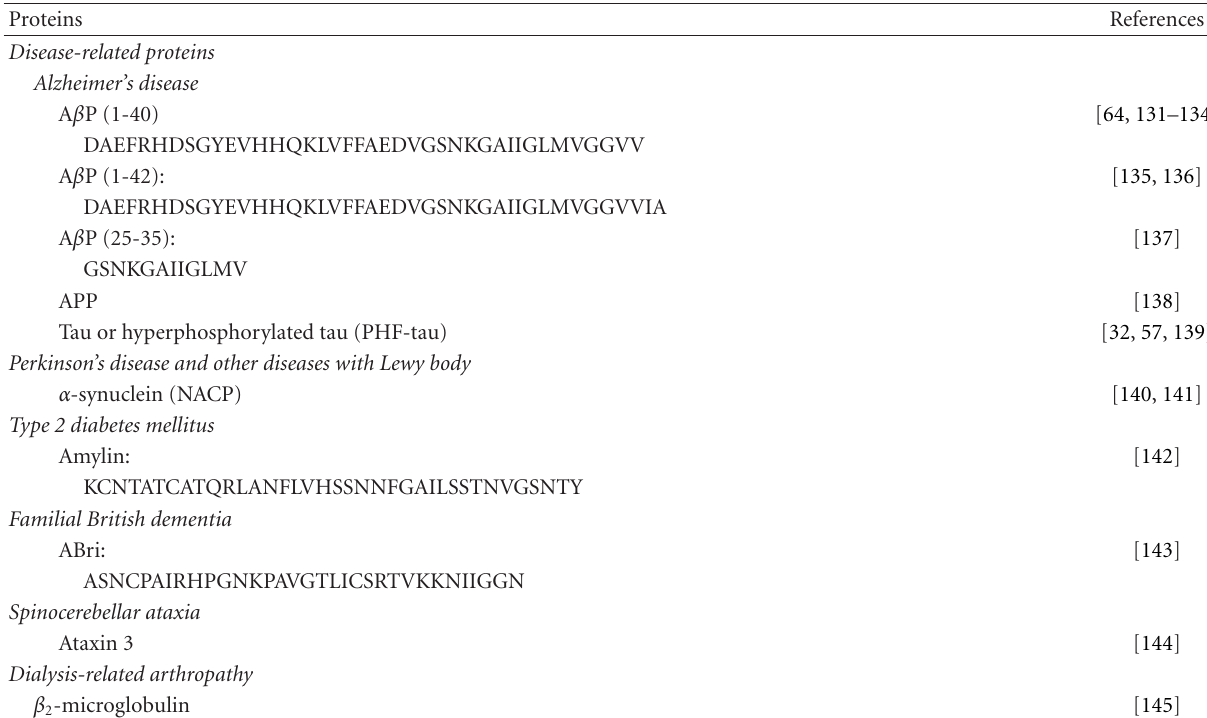
Table 2: Al-induced conformational changes of various